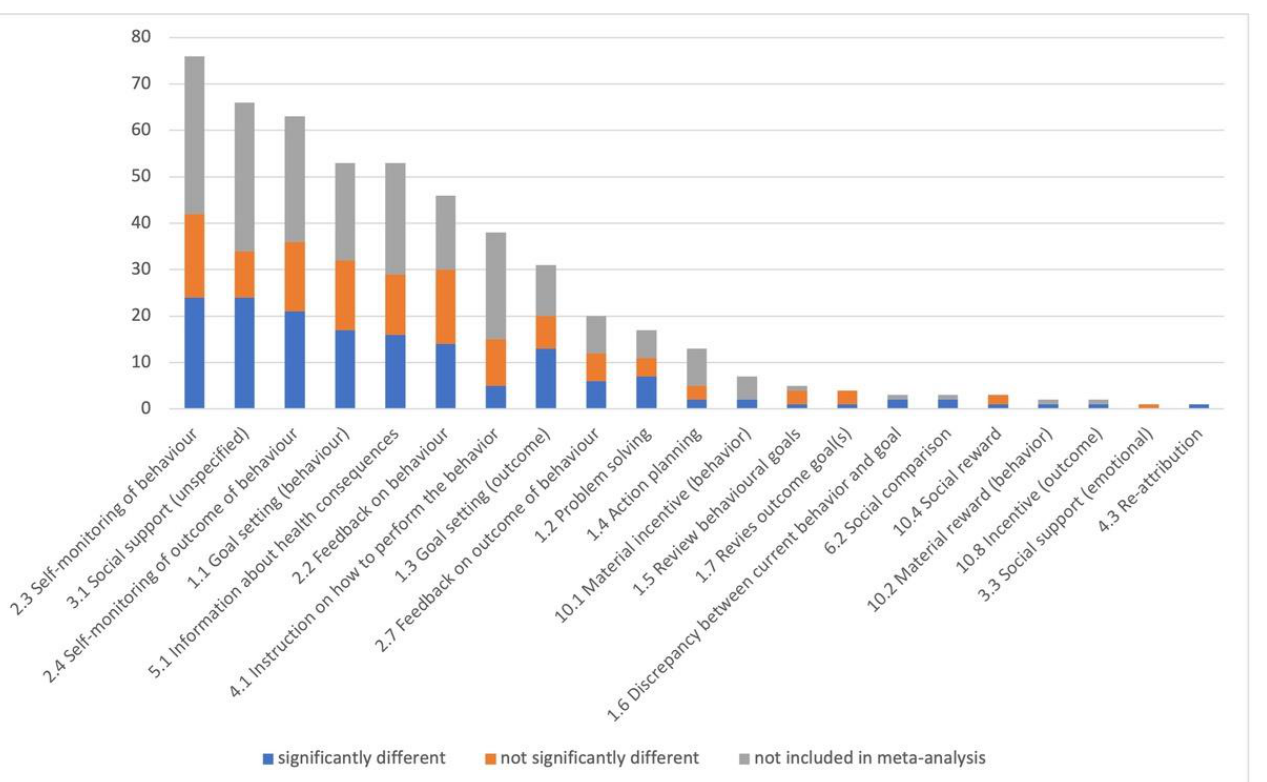
Figure 2. Number of articles including each intervention